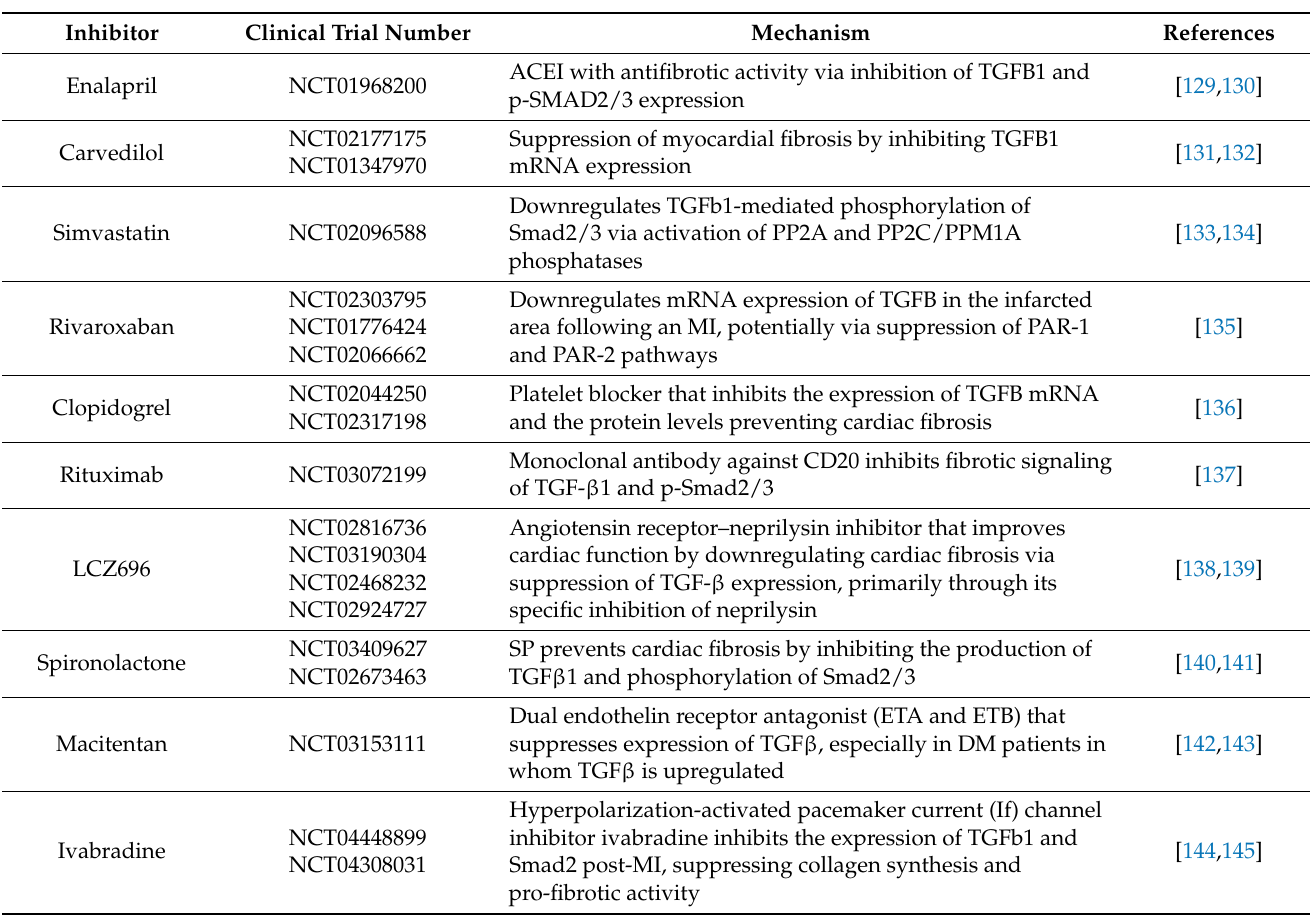
Table 1. Potential TGF- β inhibitors in active cardiotoxicity and cardiac disease-related clinical trials. The Clinicaltrials.gov database was used to assess active interventional clinical trials for the treatment of heart disease and cardiotoxicity within phase 1, 2, 3, or 4 of development. Following inhibitor identification, the literature was consulted to determine any hypoxia-modulating effects.